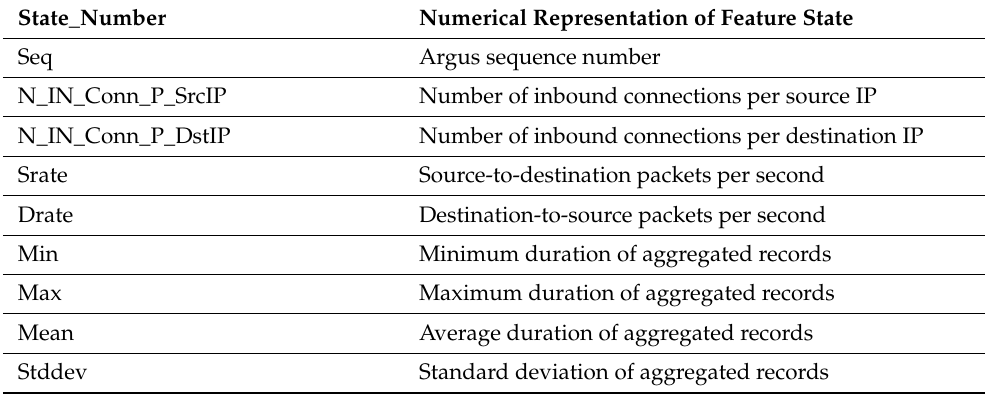
Table 2. The description of BoT-IoT best